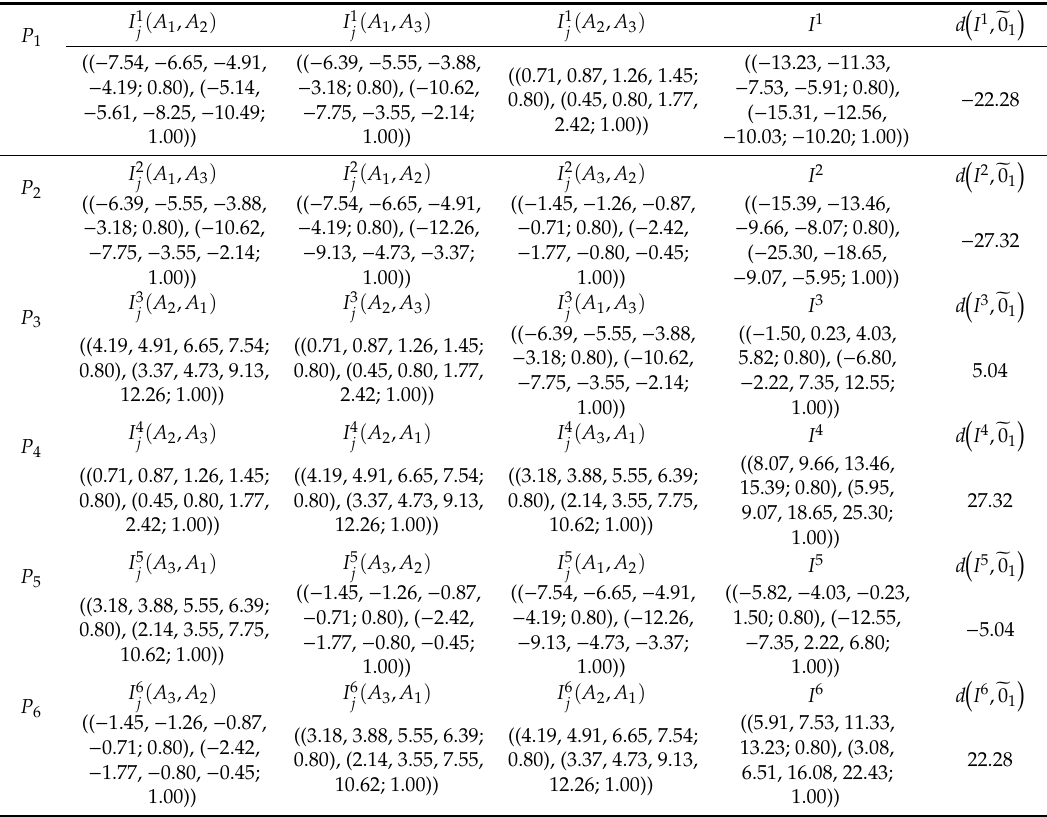
Table 8. Comprehensive concordance / discordance index.